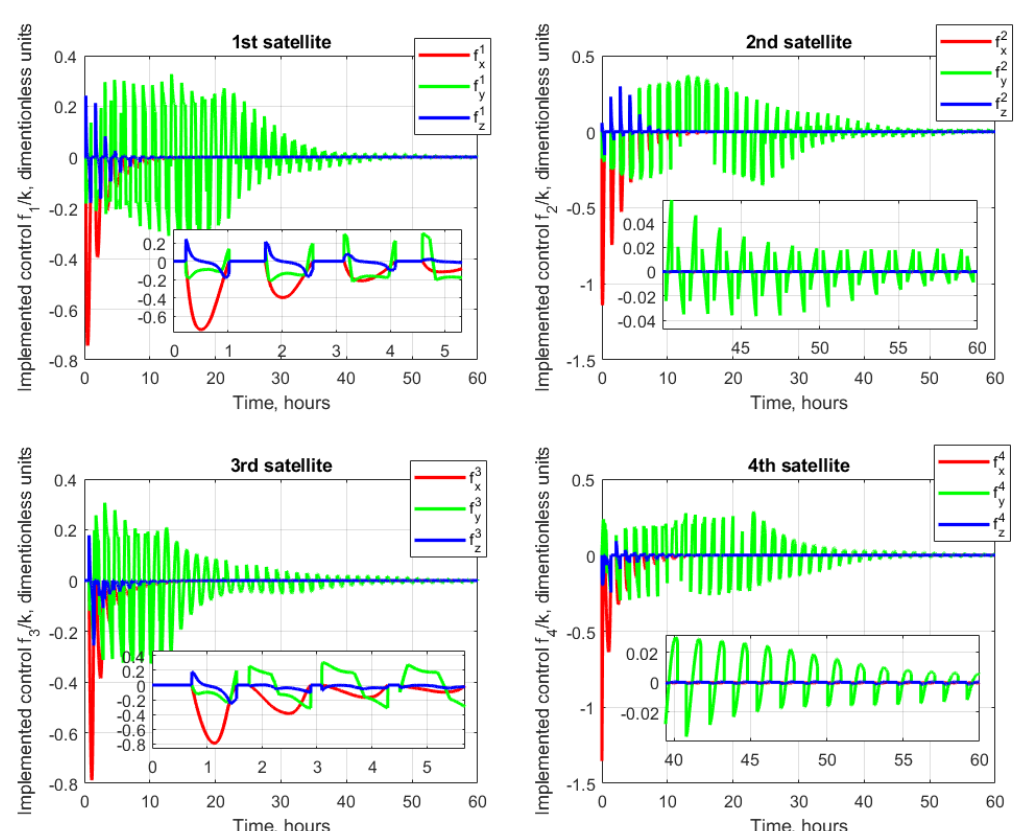
Figure 7. The implemented control according to the restrictions of Equation(10).